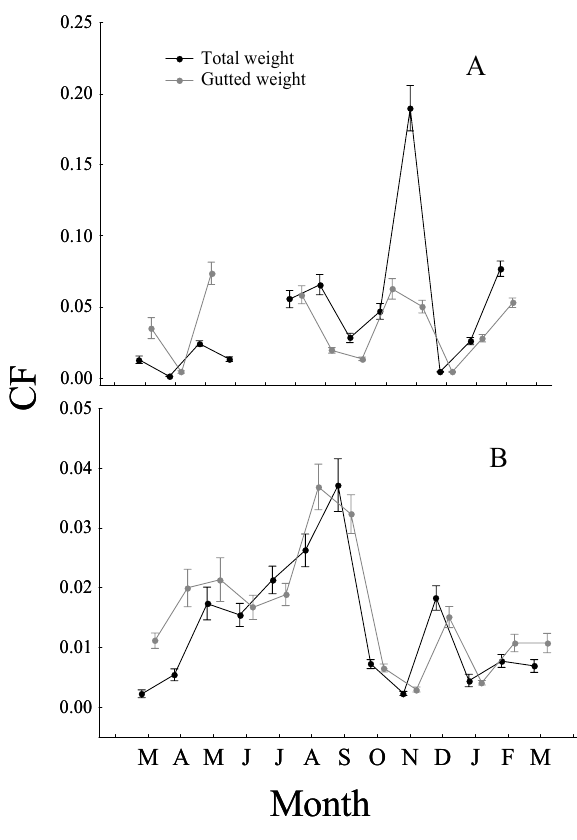
Fig. 6. Median condition factor by month (from March, 2005 to March, 2006) considering total (black line) and gutted weight (g) (grey line) for males (above) and females (below) of Rioraja agassizi. Vertical bars represent the data